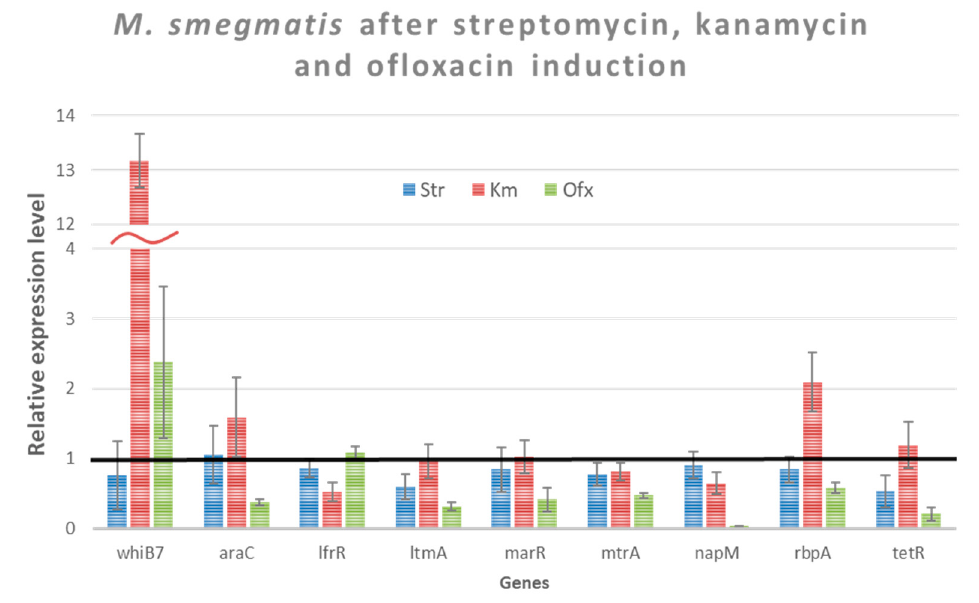
Figure 2. The relative level of the studied genes expression in cells of M. smegmatis cultivated in the presence of antibiotics. Expression of the studied genes in the absence of antibiotics was considered equal to 1 (black line— M. smegmatis control without induction). The error bars represent the standard deviation calculated from three independent replicates. Table 4. A 2-fold or a higher change in the expression level of genes under the antibiotic